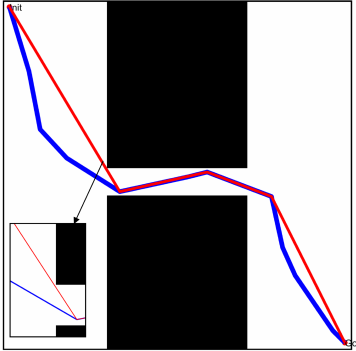
Figure 19. Path obtained by the typical path pruning technology.